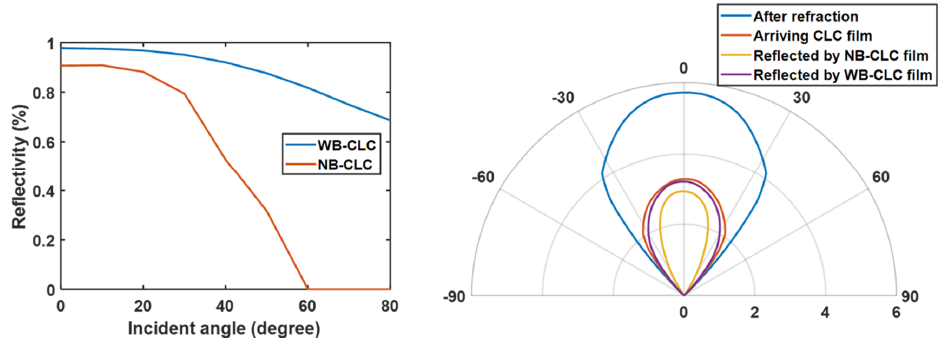
Figure 10. ( a ) Average reflectivity of WB and NB P-CLC films in the blue light spectrum (micro-LED) at different incident angles (in air). ( b ) Angular intensity distribution of blue light in the RG sub-pixels at different layers of the color-converted micro-LED.